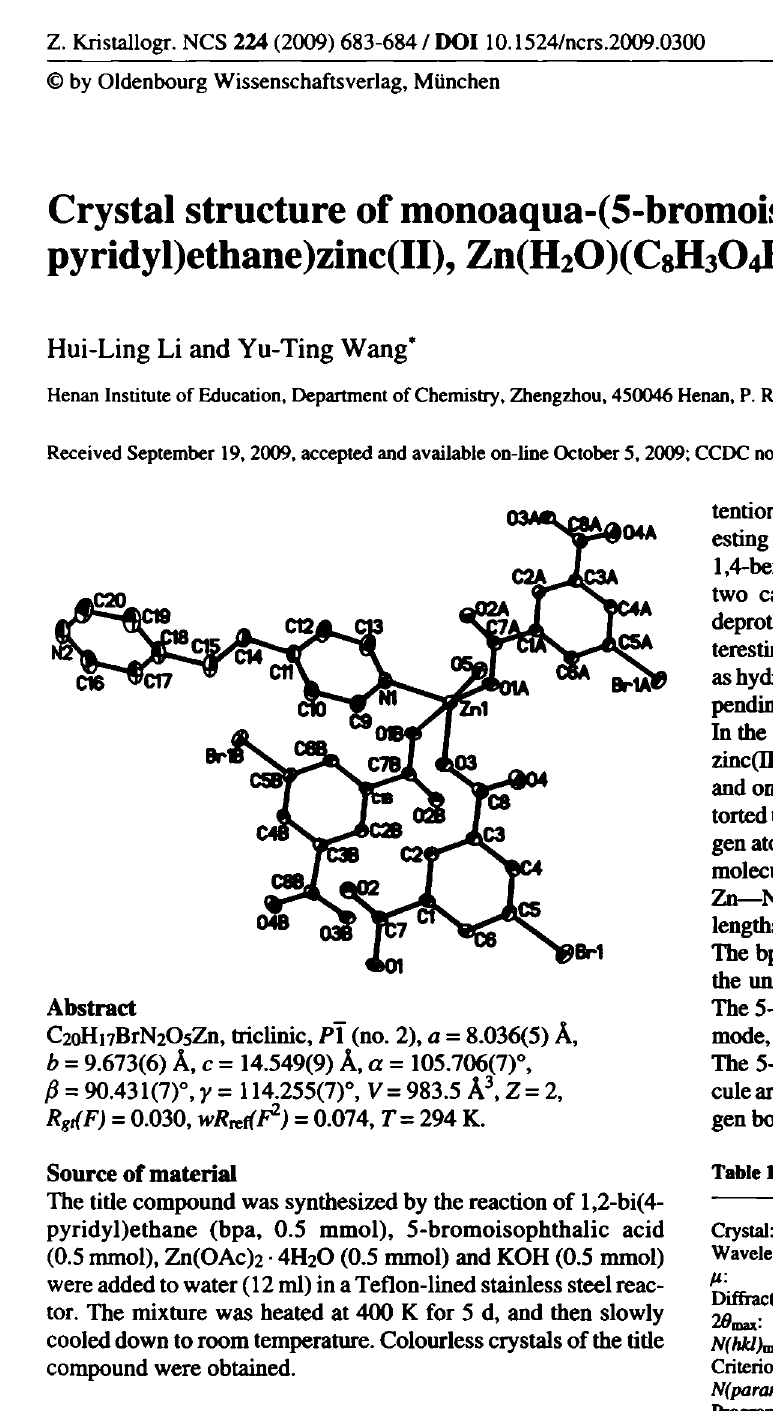
Table 2. Atomic coordinates and displacement parameters (in Â 2